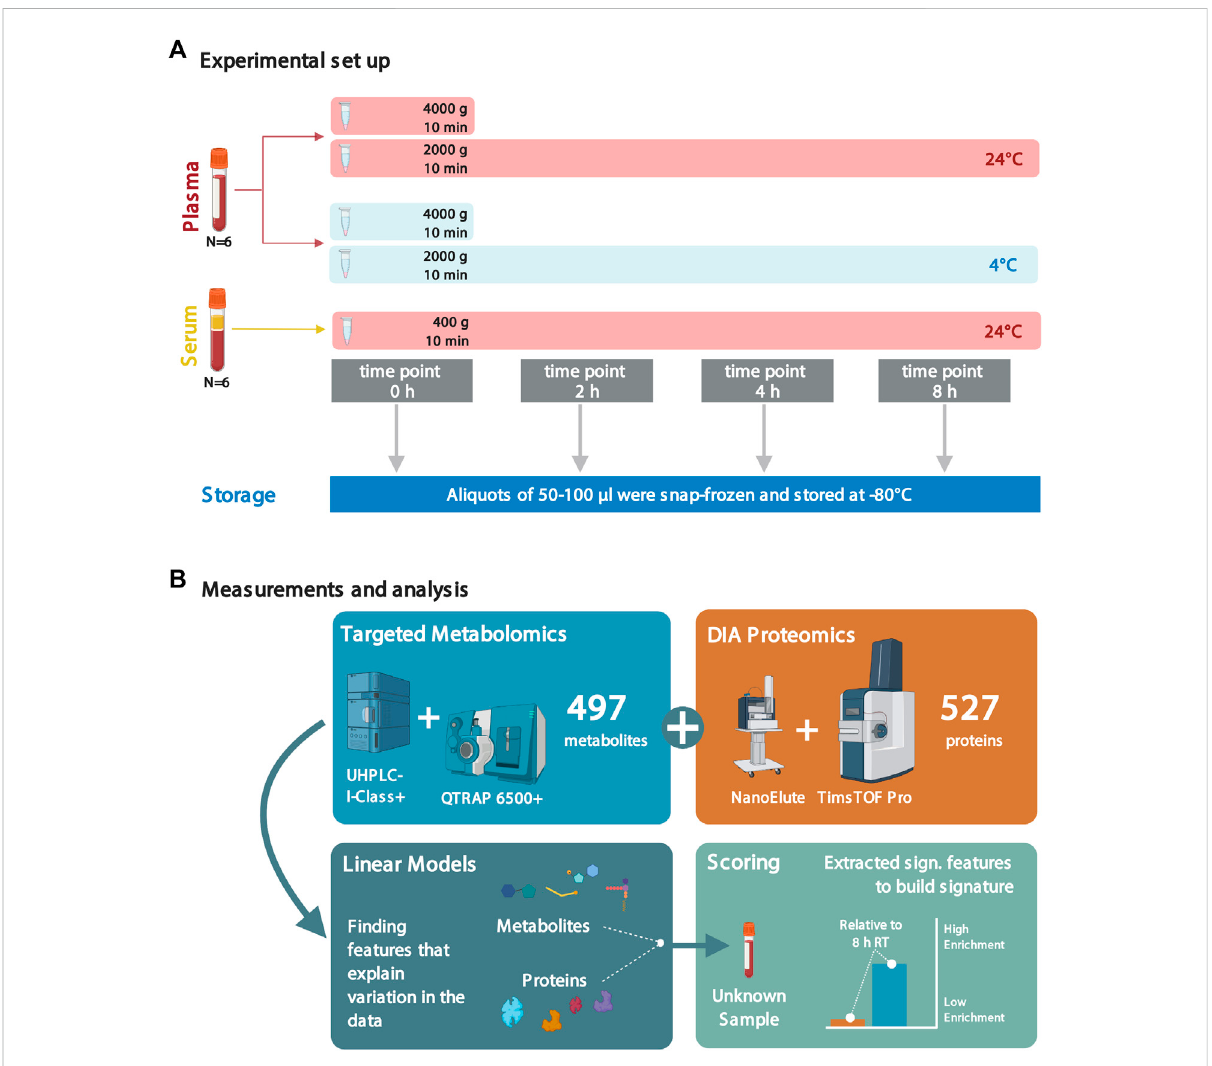
Experimental setup and analyses to assess the effects of sample handling or treatment on metabolite and protein levels. (A) Plasma and serum samplesfromsixhealthyindividuals(allmale,infastingcondition;bloodcollectedatthesametimeofthedayintheearlymorning)weresubjectedto differentsample treatment and handling conditions: sitting times of0, 2, 4, and 8 h; incubation temperatures of 4 ° C and 24 ° C (RT); and two different centrifugallevels(2,000and4,000×g)fortheplasmasamples.Duetoqualityconsiderations,themetabolomicsdatasetonlyconsistedofdata from fi ve individuals (see Methods). (B) Following the factorial outline, metabolite and protein levels were obtained by mass spectrometry. Next, proteomic and metabolomic data were analyzed using linear models. The signi fi cant features were extracted and used to build scores to assess sample quality. Several fi gures were created with